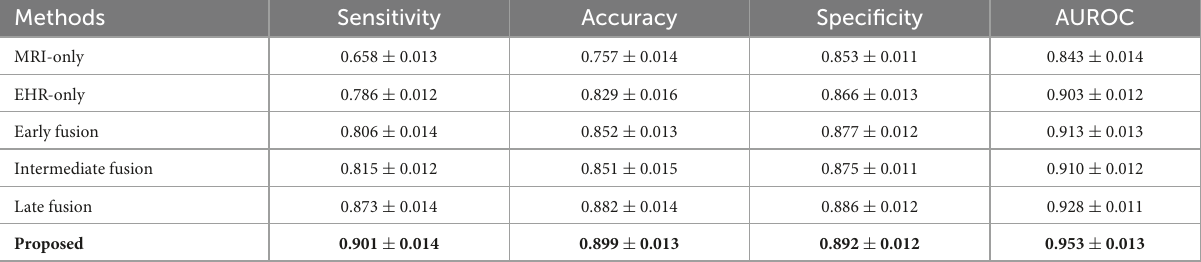
TABLE 4 Performance comparison of the MRI-only method, the Electronic Health Records (EHR)-only method, the early fusion method, the intermediate fusion method, and the late fusion method on the test Alzheimer’s Disease Neuroimaging Initiative (ADNI)